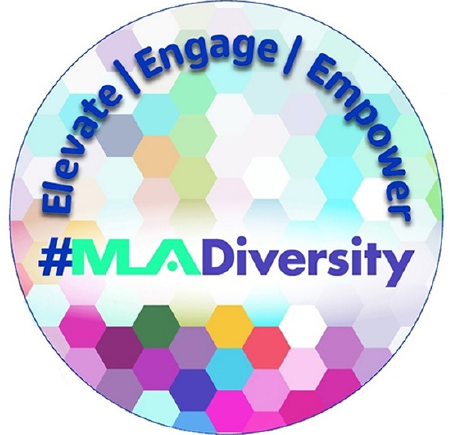
Figure 3 MLA ’18 diversity button